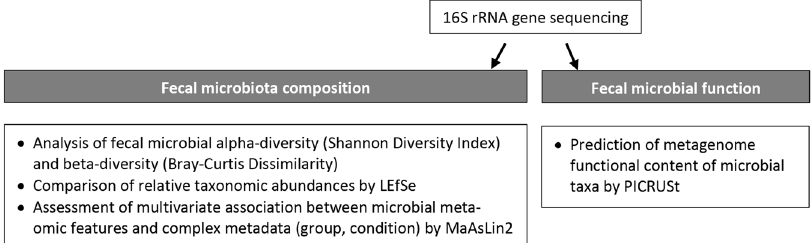
Fig. 1 Fecal microbiome data analysis work fl ow. After DNA extraction and next generation 16S rRNA gene sequence analysis, fecal microbiota composition and function were assessed. The study of fecal microbiota composition included alpha- and beta-diversity measurements, the comparison of relative taxonomic abundances using linear discriminant analysis effect size (LEfSe), and the assessment of the relationship between clinical metadata (groups of baboons; drinking and abstinence conditions) and microbial community abundance using multivariate microbial association by linear models (MaAsLin2). The study of fecal microbiota function was based on the analysis of genetic functional potential using phylogenetic investigation of communities by reconstruction of unobserved states (PICRUSt) based on the Kyoto Encyclopedia of Genes and Genomes (KEGG)